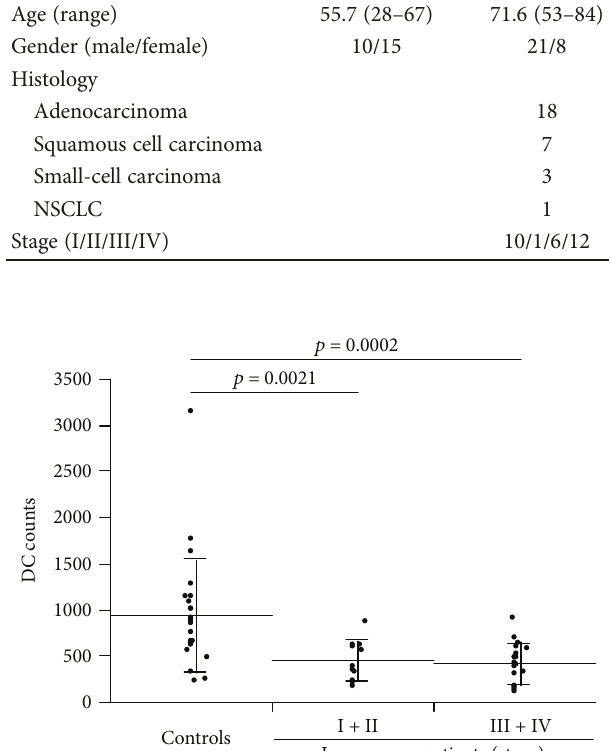
Figure 1: Peripheral blood dendritic cell (DC) count. After adding monoclonal antibody, peripheral blood samples were hemolyzed, and cell immobilization was conducted. HLA-DR(+) and Lineage- 1( − ) DC fractions were identi fi ed using a FACSCalibur, and the number of cells per 200,000 leukocytes was analyzed. Signi fi cant di ff erences were observed between the stage I+ II lung cancer patients and the controls ( p = 0 0021 ) and between the stage III+IV lung cancer patients and the controls ( p = 0 0002 ). Horizontal lines represent the means, and vertical lines represent the standard deviation.